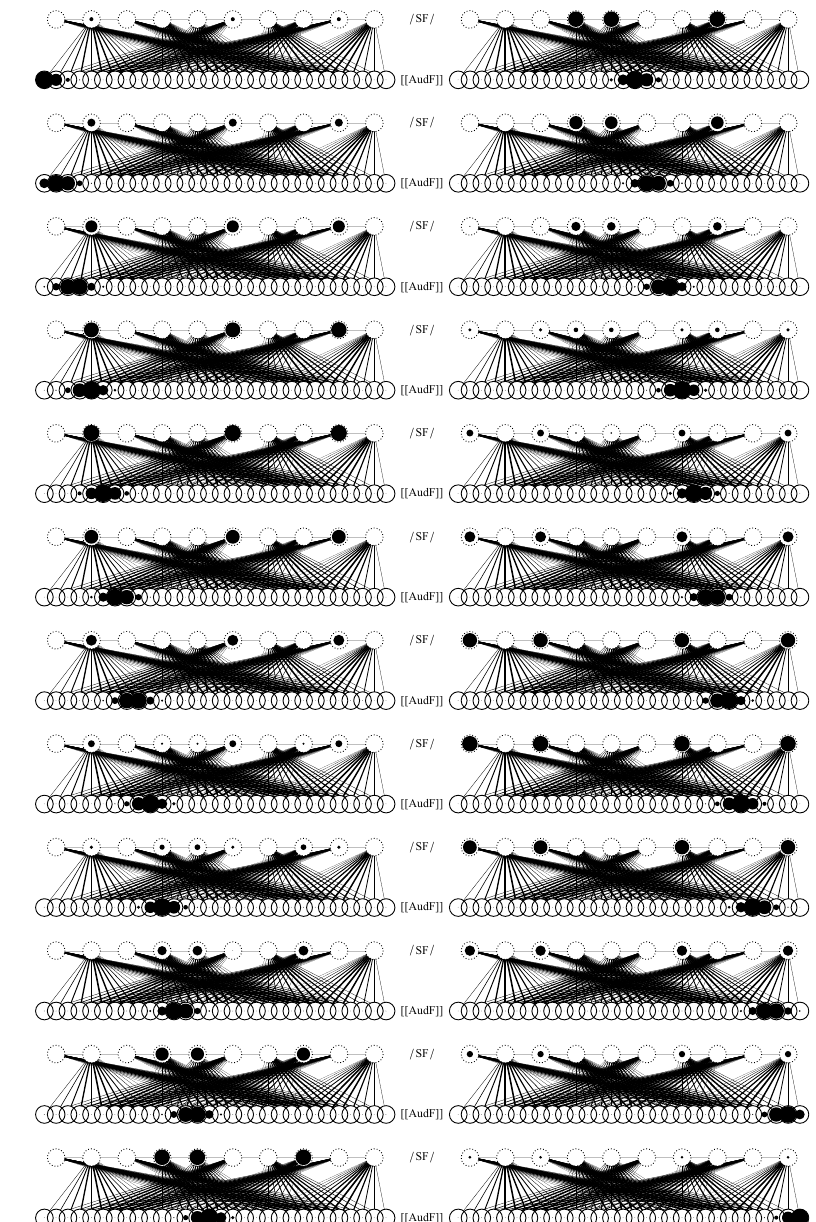
Figure 16: Pacing the trained network through the Auditory Form yields three types of patterns in the Surface